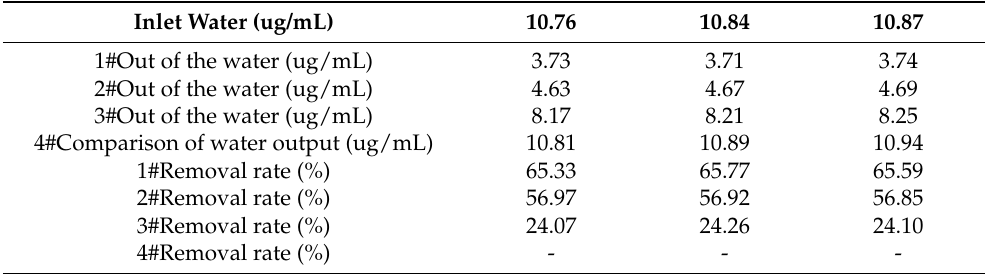
Table 4. The protein content variation in three addition methods with Phanerochaete chrysosporium . Inlet Water (ug/mL)